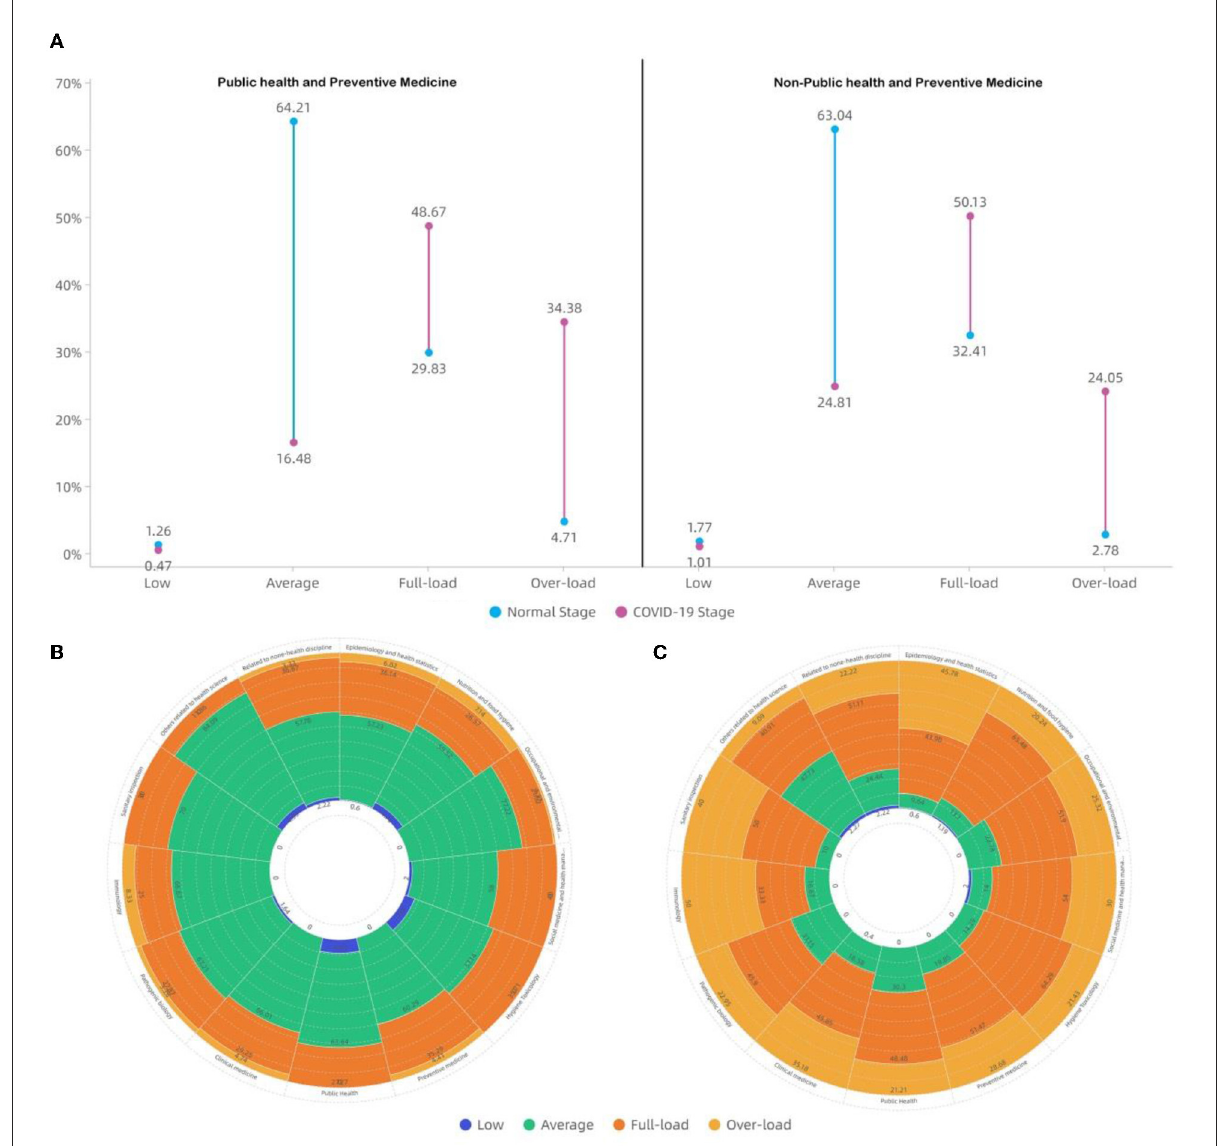
FIGURE3 Distribution of work stress in different disciplines before and during the COVID-19 pandemic within the Beijing Disease Prevention and Control System. (A) Shows the change in different work stress levels between Normal stage (pre-COVID-19 pandemic) and COVID-19 stage in the P group and N-P group. (B) Shows the works stress level in different disciplines during the normal stage. (C) Shows the works stress level in different disciplines during the COVID-19